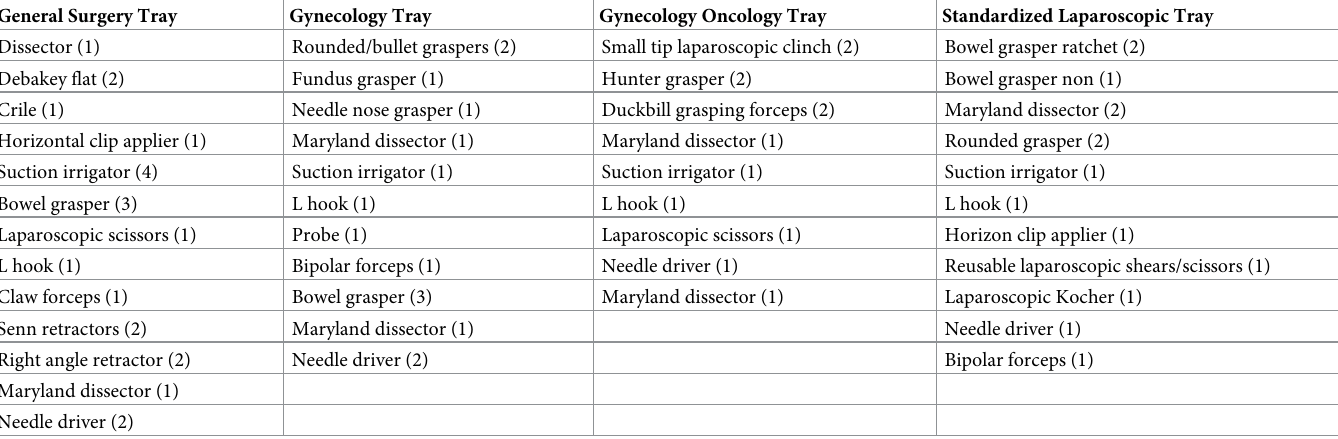
Table 3. Configuration of the various trays used in this